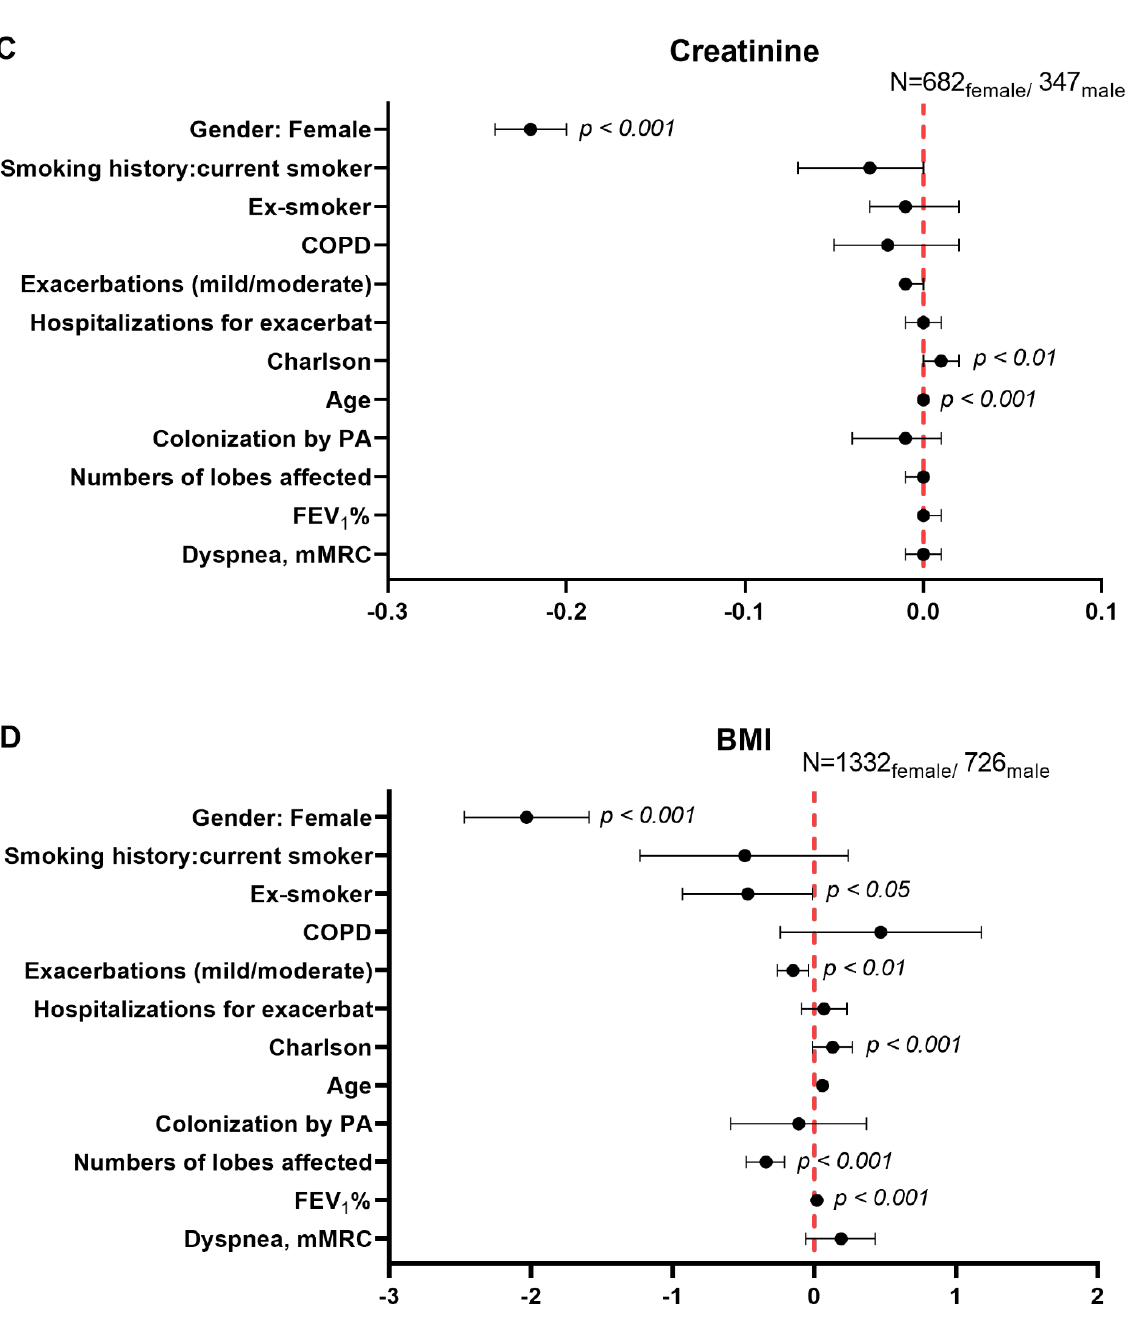
Figure 5. Independent associations between female gender and the following variables: hemoglobin levels ( A ), hematocrit levels ( B ), creatinine levels ( C ), BMI values ( D ). Multivariate robust regression analysis was used to perform the analysis. Confidence intervals and statistical significance are represented in each figure panel. Beta coefficients are represented as black dots. The zero value is represented as a red dotted vertical line in each forest plot. The model was adjusted by age, smoking history (never, current, or ex-smokers), exacerbations mild-moderate, hospitalizations due to exacerbations in the previous year, Charlson Index, colonization by PA, numbers of affected lobes, FEV 1 %, and dyspnea score for each variable.